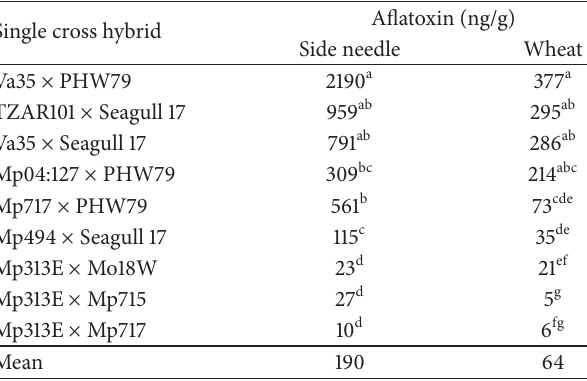
Table 1: Geometric means for aflatoxin accumulation in 10 maize single cross hybrids grown at Mississippi State in 2011 and 2012 following inoculation with A. flavus using the side-needle technique or infected wheat